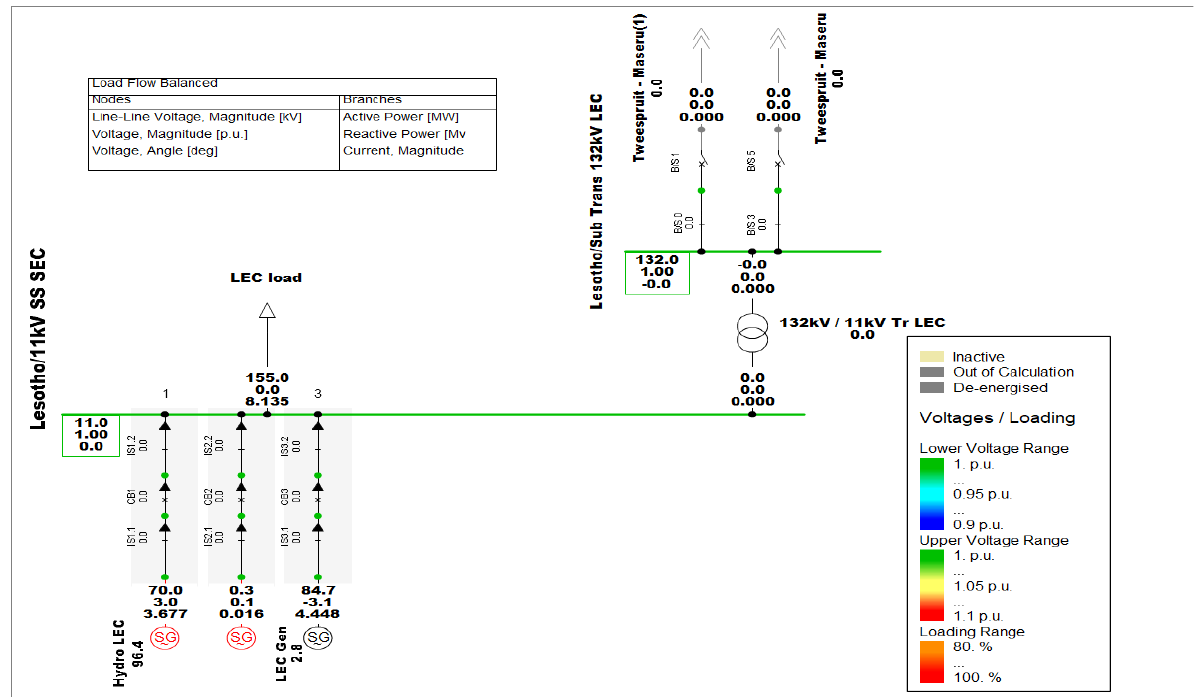
Energies 2023 , 16 , x FOR PEER REVIEW Figure 5. Southern African regional proposed network model. Figure 5. Southern African regional proposed network model.